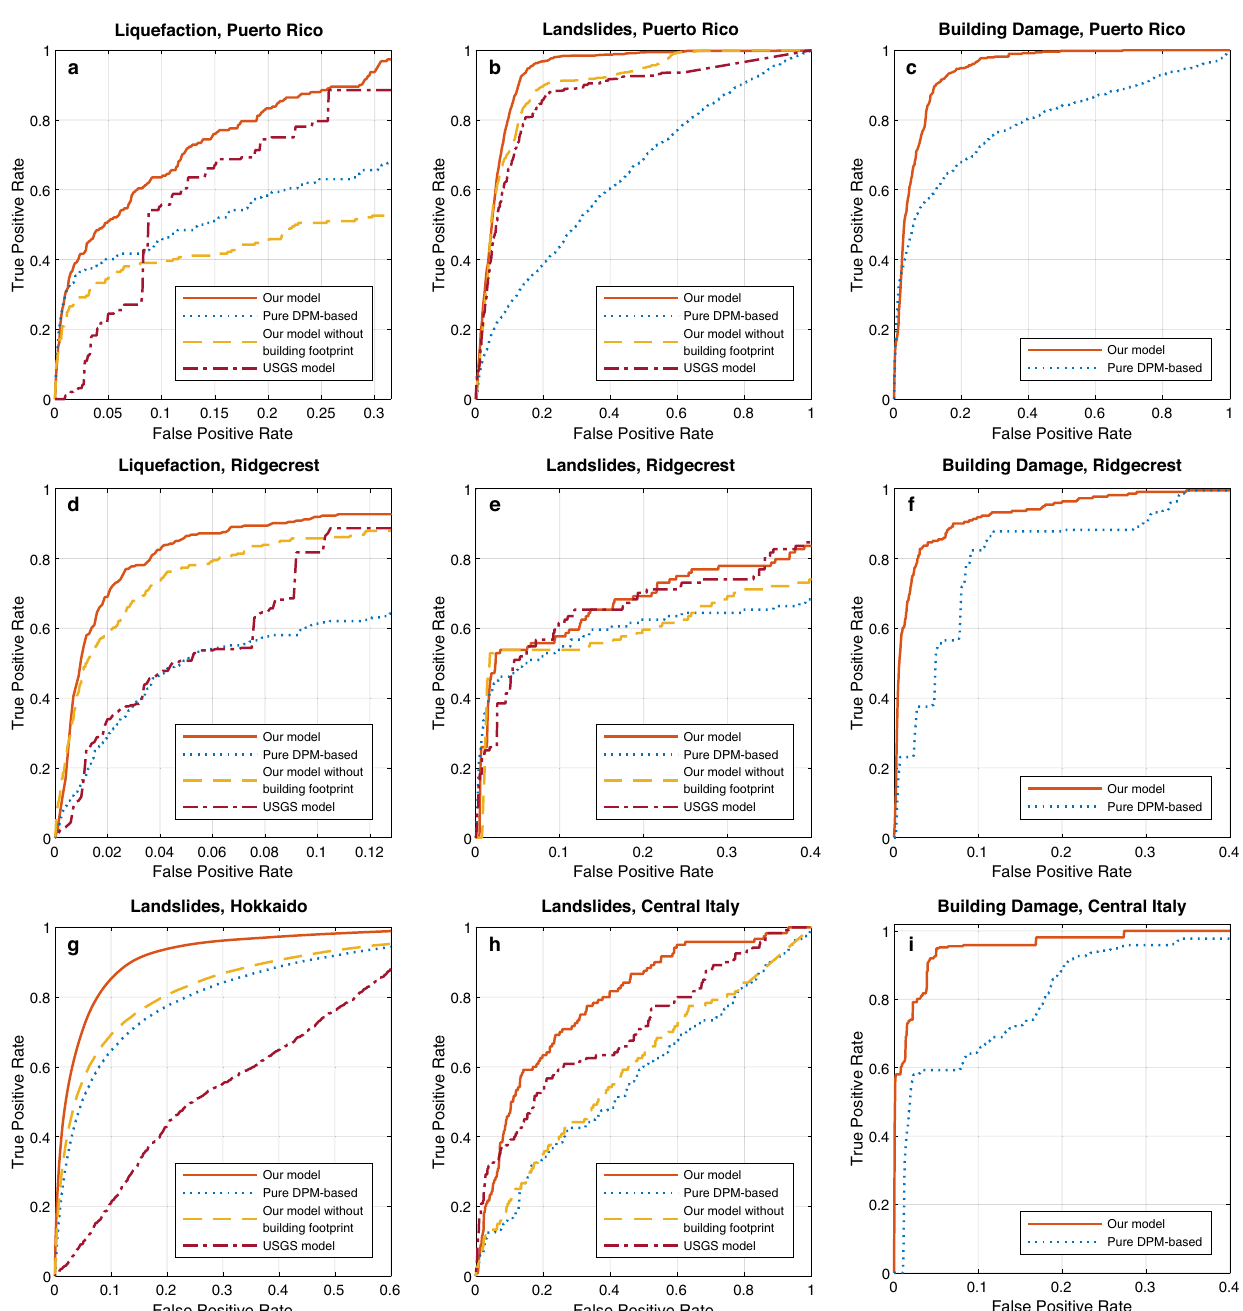
Fig. 2 | Comparisons of receiver operating characteristic (ROC) curves of four different earthquake events. a – c Liquefaction, landslides, and building damage ROC curves of the 2020 Puerto Rico earthquake. d – f Liquefaction, landslides, and